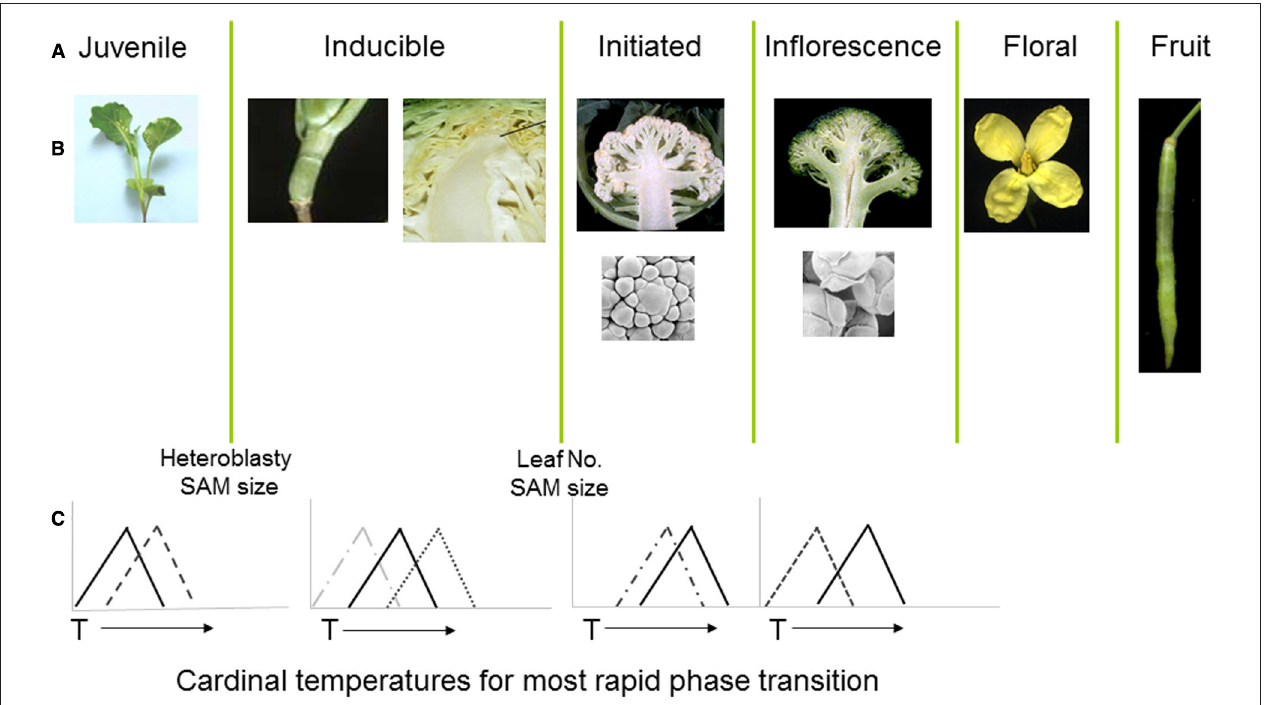
FIGURE 2 | (A,B) Distinct developmental phases and phase transitions are clearly delineated in different genotypes of Brassica oleracea . Following floral initiation in cauliflower (var. botrytis ) arrested development leads to proliferation of vegetative and inflorescence meristems, whereas in broccoli (var. italica ) development is arrested at the later floral bud stage. (C) Each developmental phase may have a distinct cardinal temperature associated with an optimal rate of growth leading to the subsequent transition. X axes represent arbitrary temperature scale; Y axis relative growth